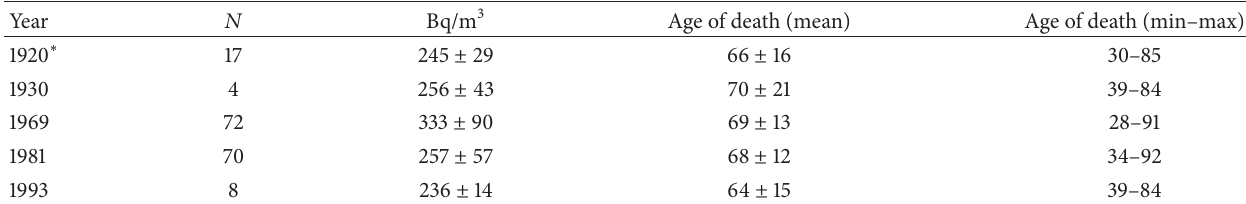
Table 3: Historical growth of Chihuahua City versus Bq/m 3 estimates for deaths georeferenced.